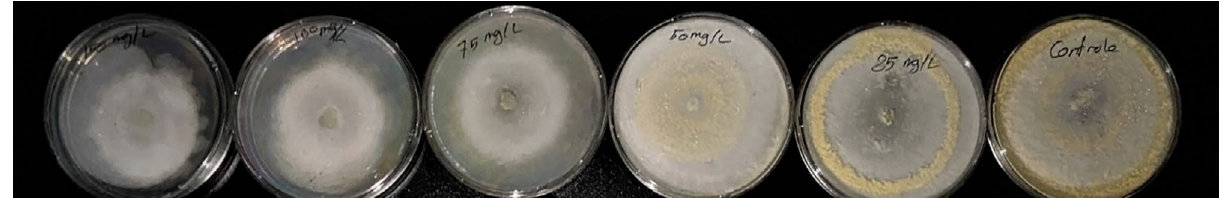
Figure 3. Growth and sporulation of T . longibraciatum isolate on PDA containing 2,6-DCP at different concentrations (150, 100, 75, 50, 25, and 0 mg/L), after 4 days of incubation